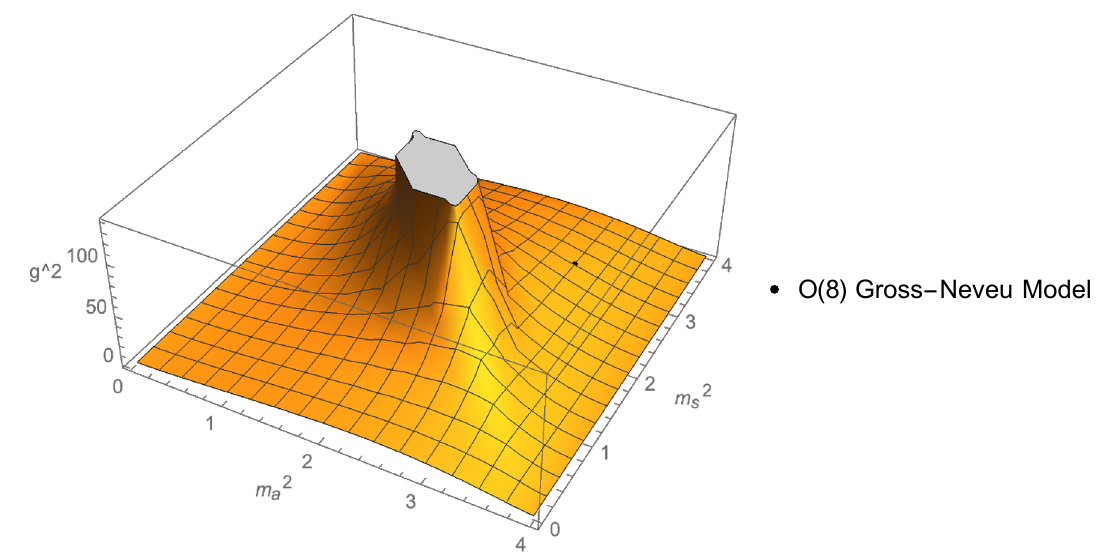
Figure 17 . O(8) bound on antisymmetric tensor coupling in presence of a scalar bound state. The O(8) Gross-Neveu model is represented by the black point which has degenerate masses.